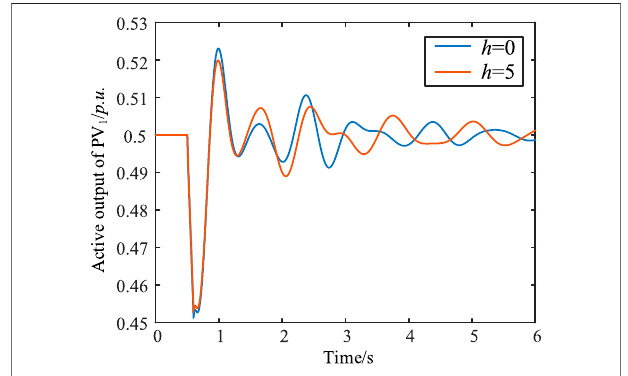
FIGURE 10 | Non-linear simulation results of the active power output of PV 1 when the electrical distance between PV farms increases.